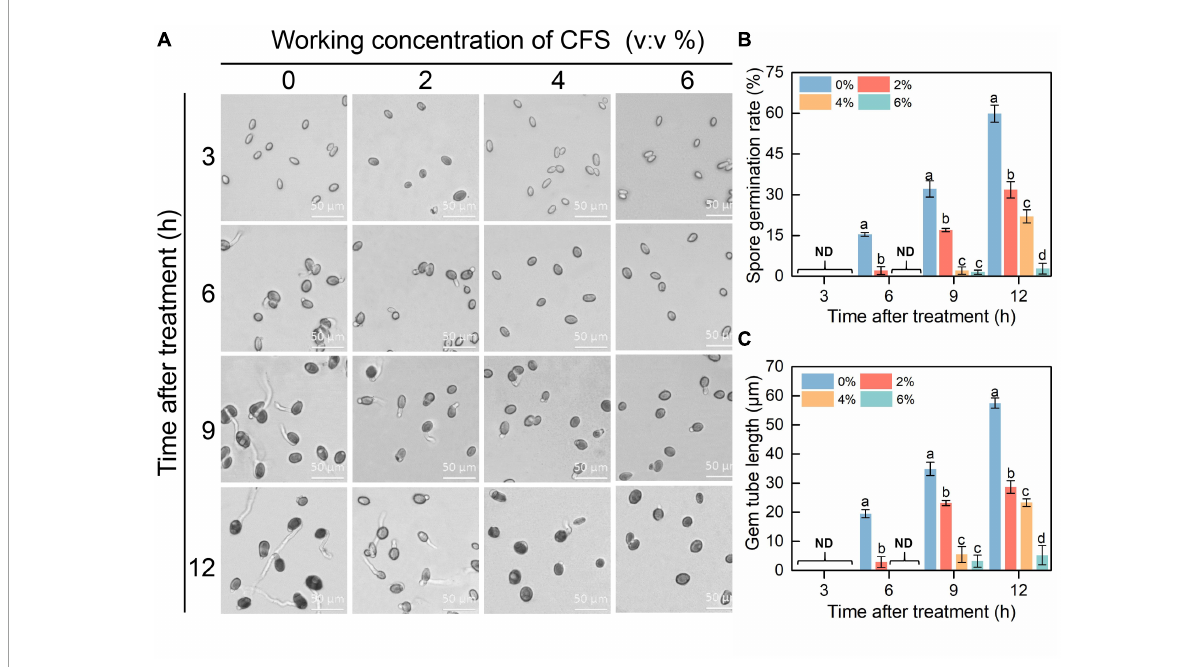
FIGURE3 The efficacy of cell-free supernatant (CFS) on spore germination and germ tube elongation of Botrytis cinerea . (A) Representative images of each treatment were recorded after inoculation every 3 h until 12 h. (B,C) Statistical analysis for spore germination (B) and germ tube elongation (C) . About 200 spores were randomly calculated in each experiment by ImageJ, and the statistical analysis was performed on triplicates of 200 spores. The standard error of the mean value is represented by a vertical bar. Columns with different letters indicated significant differences on the basis of Duncan’s multiple range test ( p <